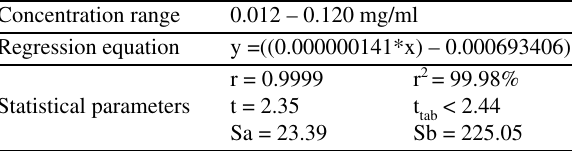
Table 1. Parameters of the regression analysis. Concentration range